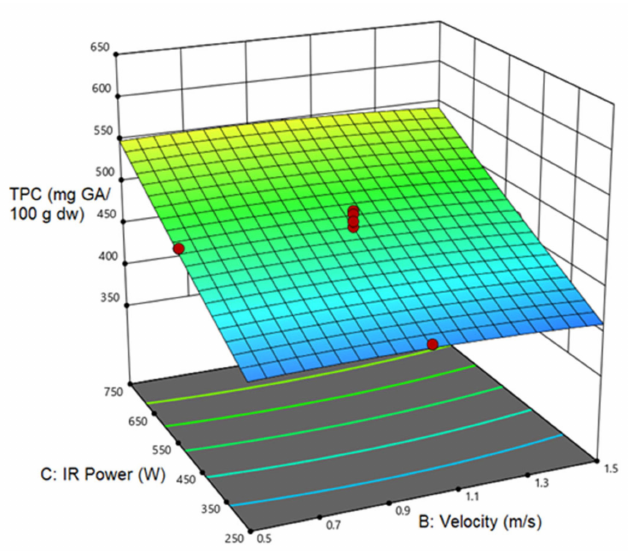
Figure 6. Interaction of air temperature/air velocity, air temperature/IR power, and IR power/air velocity on TPC of pumpkin.